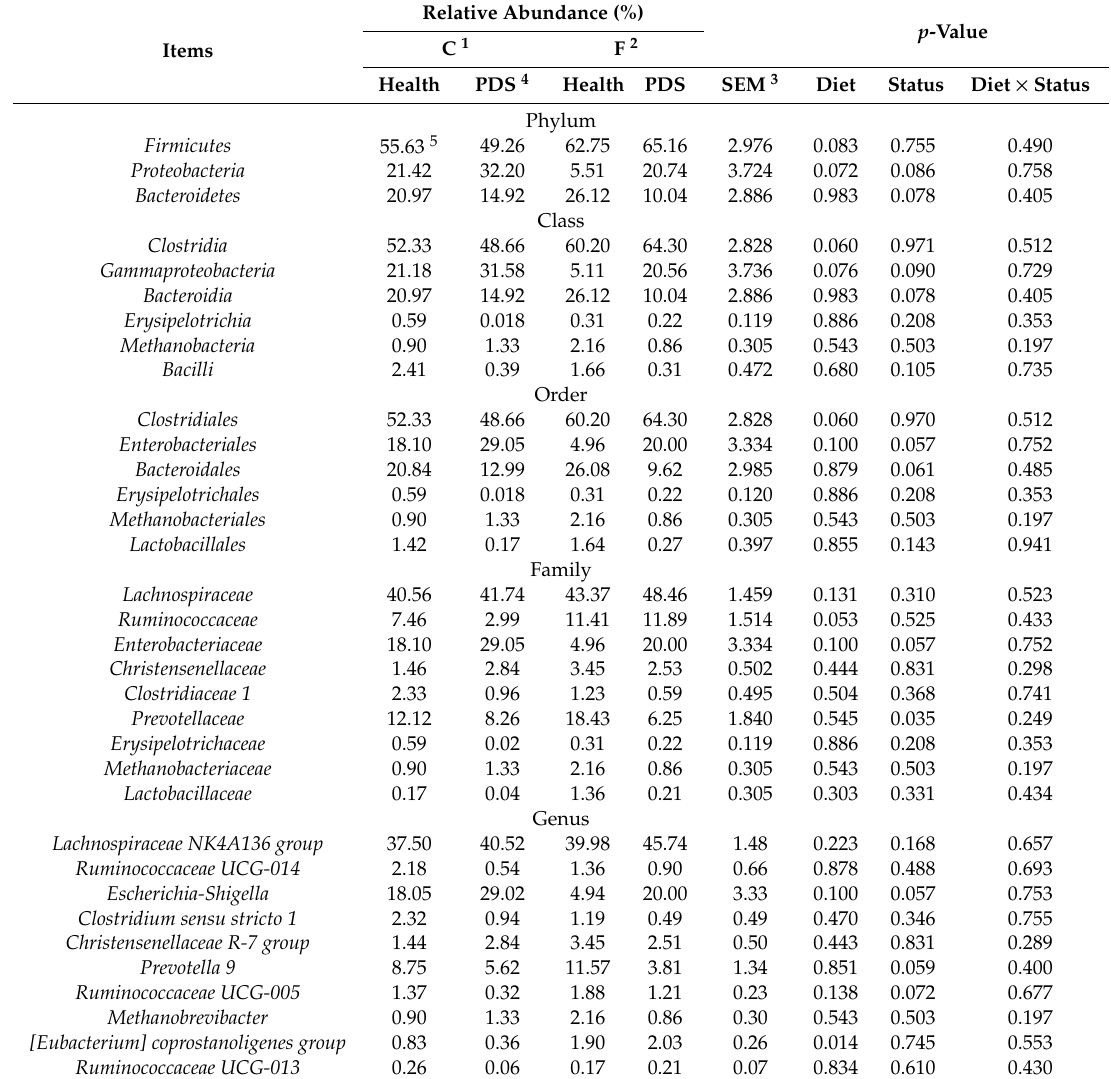
Table 6. E ff ect of Bacillus licheniformis -fermented products and postpartum dysgalactia syndrome on the bacterial classification within the fecal content of